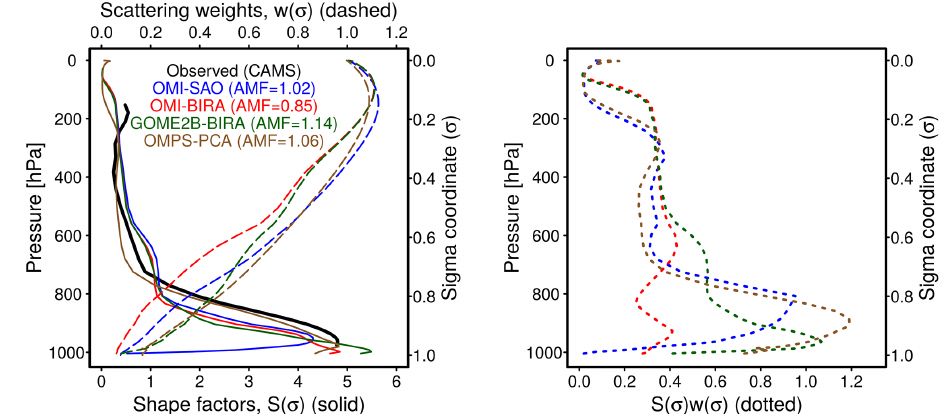
Figure 6. Air mass factor differences between retrievals. The left panel shows mean scattering weights ( w ) and shape factors ( S ) for HCHO retrievals over the southeast US during the SEAC 4 RS period, and the right panel shows the product of the two from which the AMF is derived by vertical integration using Eq. (3). Values are shown for the OMI-SAO, OMI-BIRA, GOME2B-BIRA and OMPS-PCA retrievals. Mean AMF values are given in the legend. Also shown is the observed HCHO shape factor (black) from the mean CAMS profile in Fig.